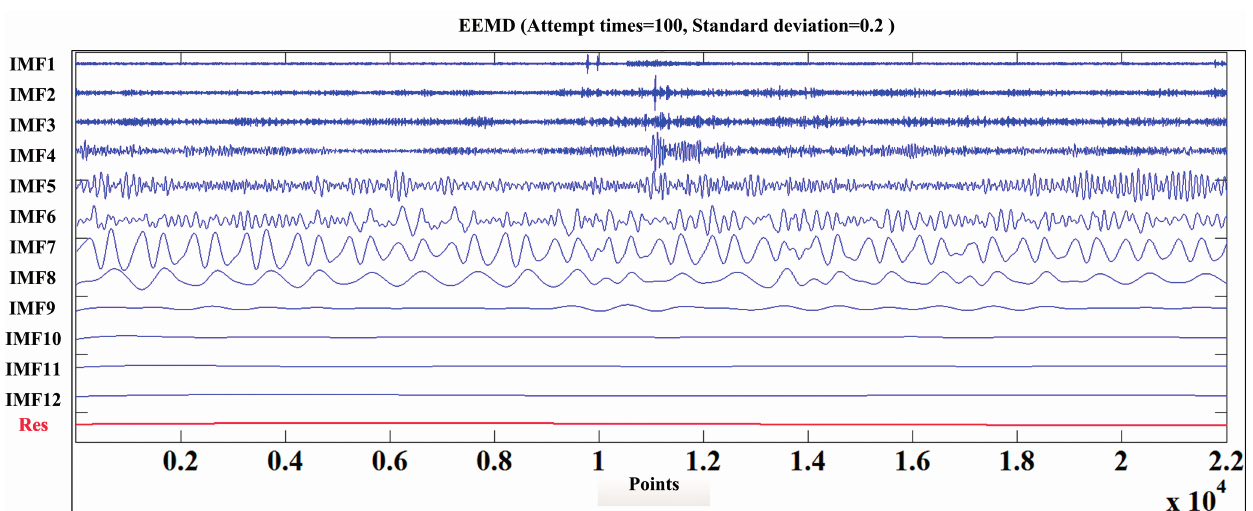
Figure 4. The initial sound series of the five patterns. ( a ) pure coal seam with the hardness of f2; ( b ) pure coal seam with the hardness of f3; ( c ) pure hard rock seam; ( d ) coal seam gripping gangue; ( e ) no-load.